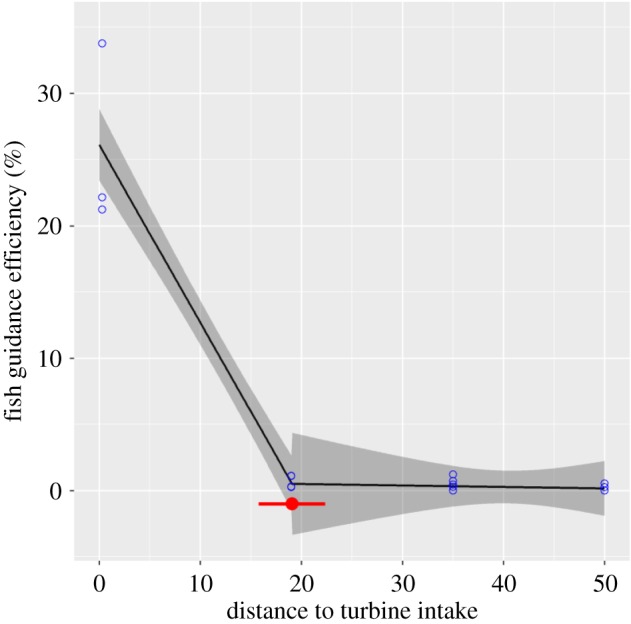
Predicted FGE for different surface gates in the hydropower dam as the distance from the turbine intake (m). Breakpoint estimate with corresponding standard error bars is shown in red. Shaded areas correspond to 95% confidence bounds.